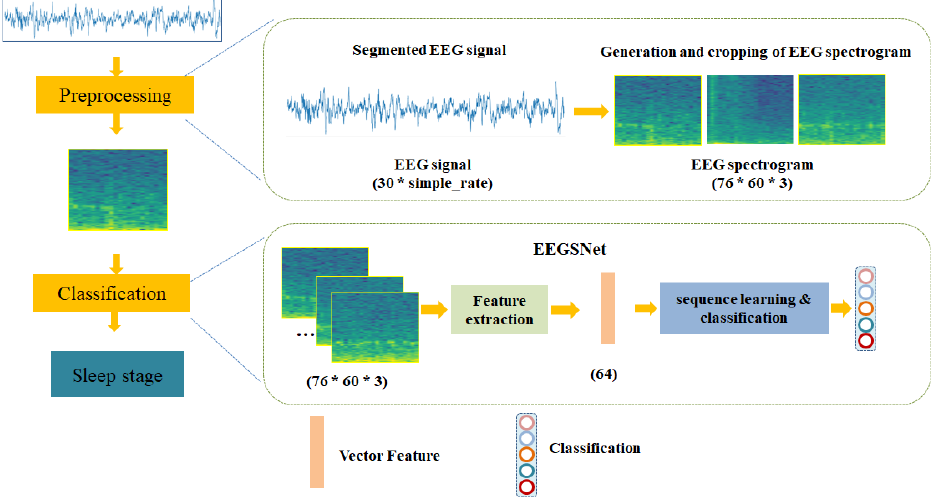
Figure 4. Flowchart of the proposed sleep stage classification method.